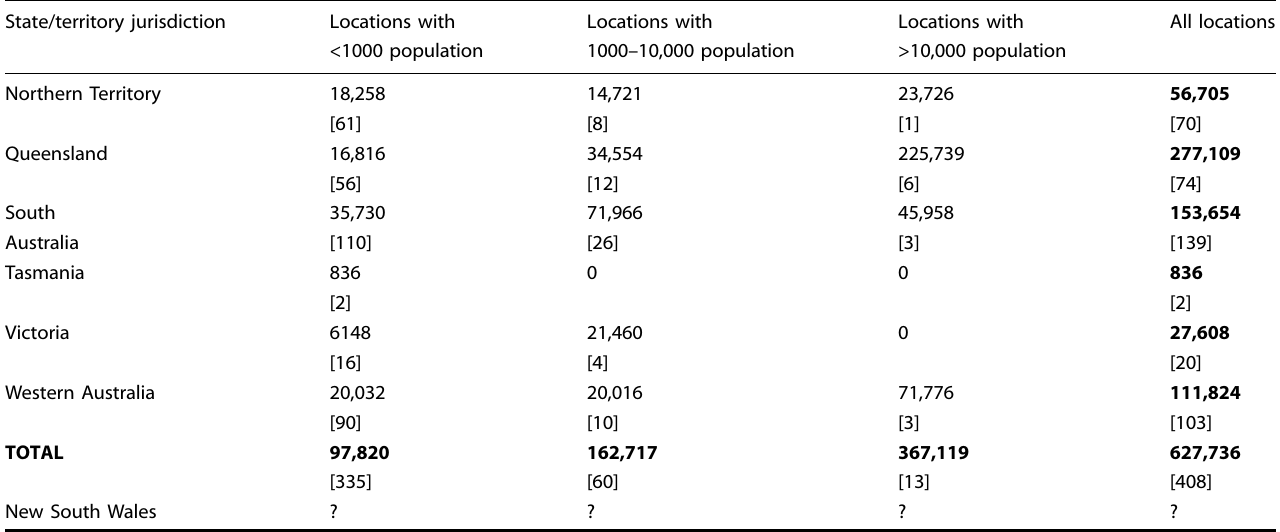
Table 4. Population and number of locations in regional and remote Australia reported to lack access to the ‘ ADWG Good ’ de fi nition of a basic level of drinking water